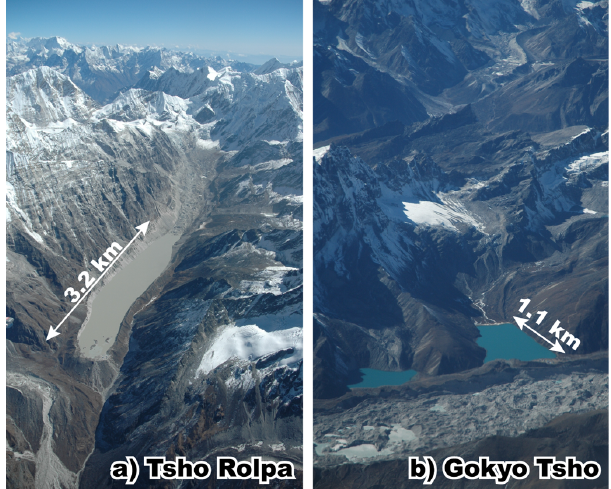
Fig. 3. (a) Moraine-dammed lake examined in this study (Tsho Rolpa having the greatest potential flood volume) and (b) glacier- dammed lake excluded from the analysis (Gokyo Tsho). Both lakes are in Nepal. Photos taken in November 2007.